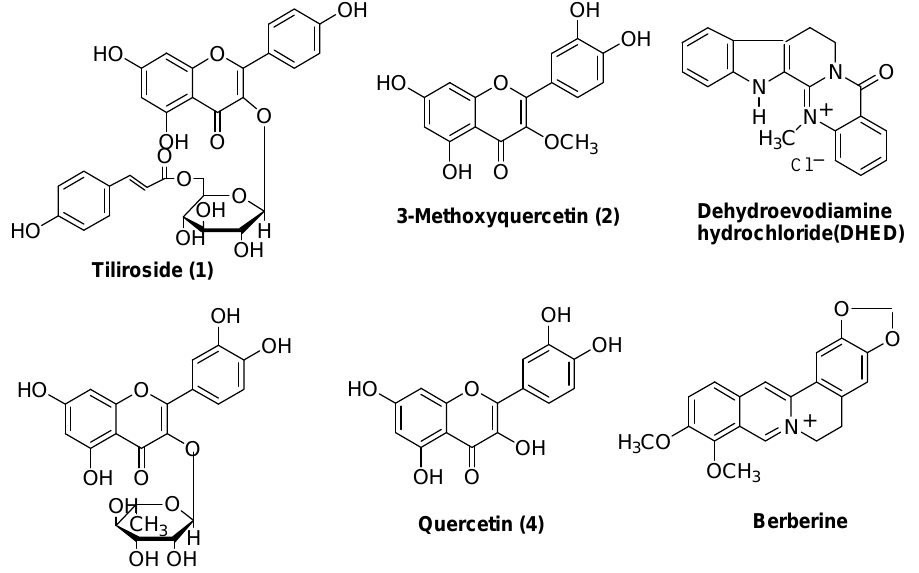
Figure 2 . The flavonoids 1-4 isolated from Agrimonia pilosa ledeb and structures of DHED and